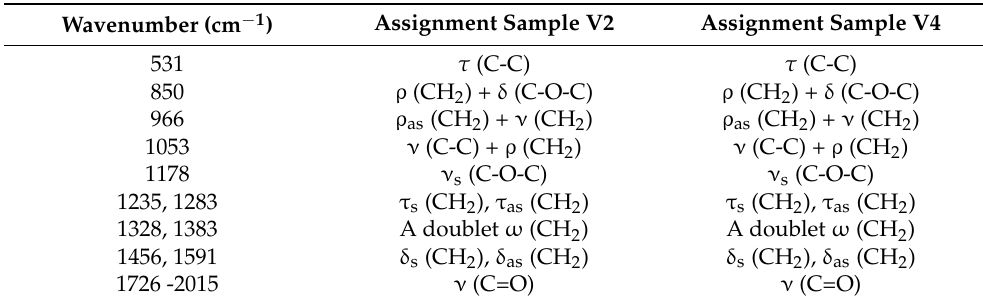
Table 4. Wavenumbers and assignments of IR bands exhibited by samples V2 and V4. Where ν = stretch, δ = scissor/deformation, ω = wag, ρ = rock, τ = twist. The subscripts s and as refer to sym- metric and asymmetric vibrational modes, respectively.